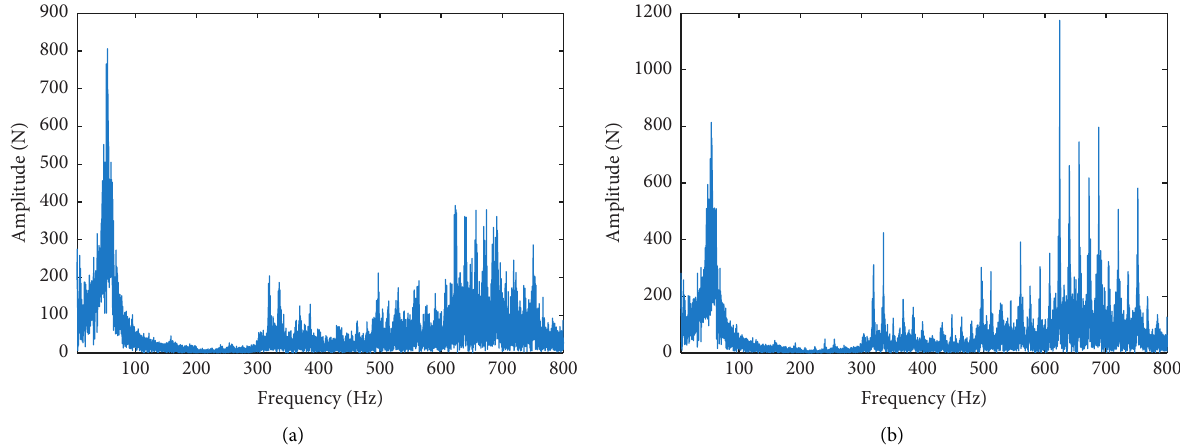
Figure 9: Effect of tunnel differential settlement on the frequency spectrum of the wheel-rail contact force. (a) Without differential settlement. (b) With differential settlement.